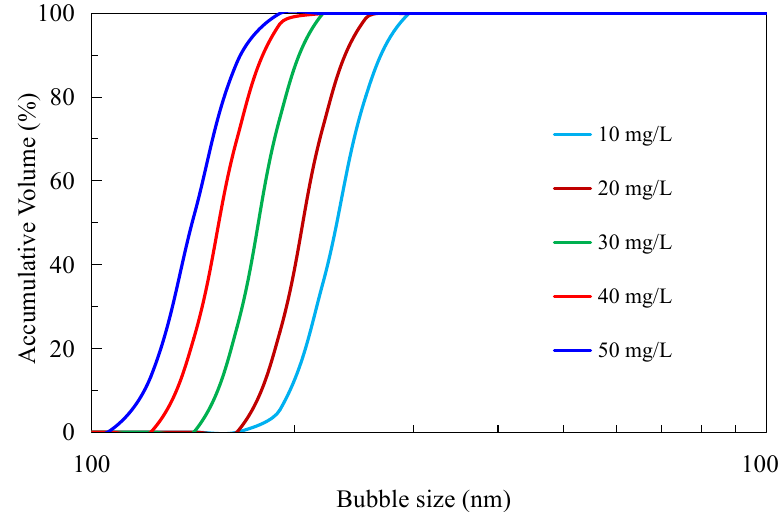
Figure 3. Nanobubble size distribution at different frother concentrations at pH 6.